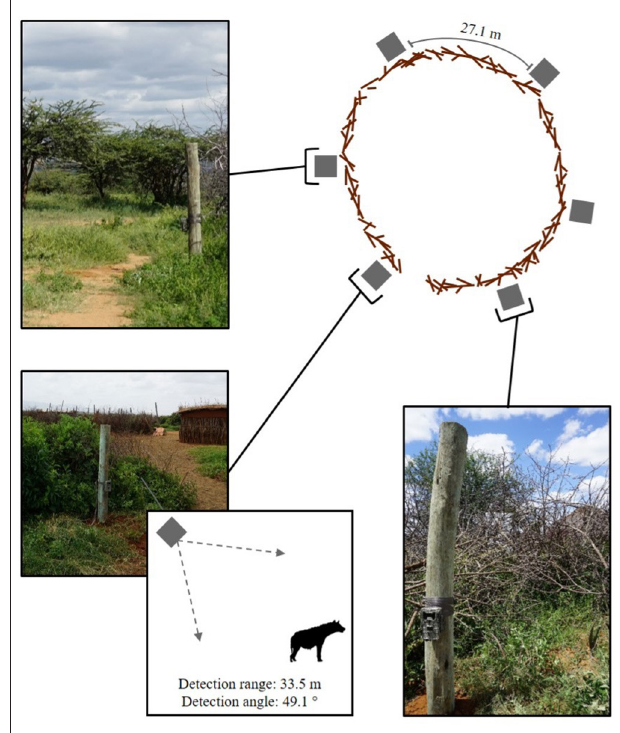
FIGURE 3 | The location of the motion-activated cameras around the perimeter of one the 12 bomas in Central Kenya. The diagram indicates the position of the cameras in relation to the boma wall, the average distance between cameras, and the camera detection range and angle. The photographs show the placement of the cameras on the fence